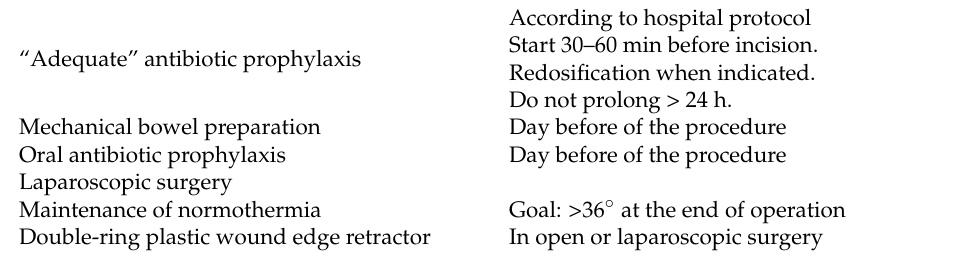
Table 1. Measures included in the VINCat colorectal bundle.